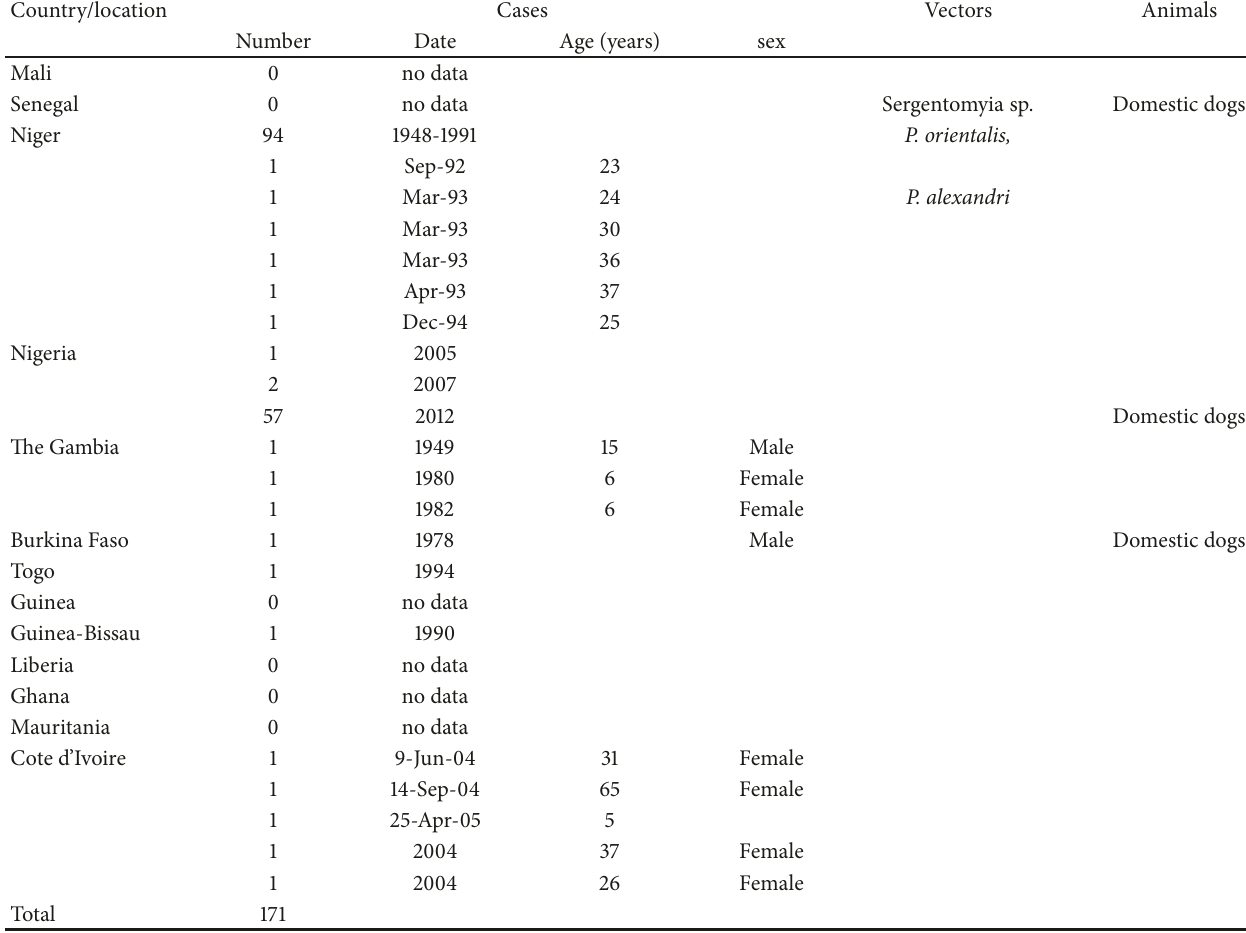
Table 1: VL cases, vectors, and animals in West